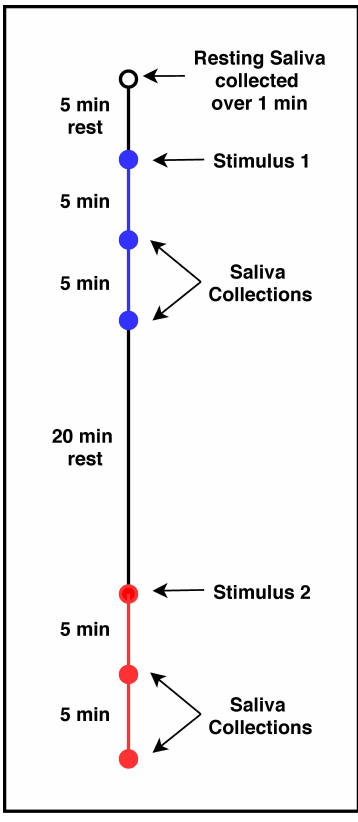
Figure 1. Saliva collection